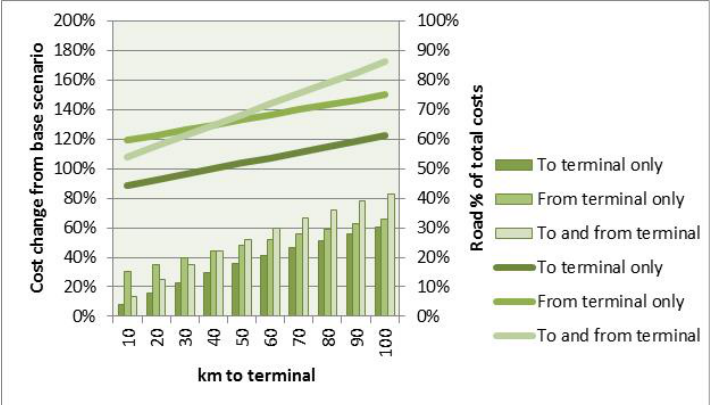
Figure 14. Effect of changed road distance to and from terminal. The lines represent the change in total costs and the bars the road’s share of total